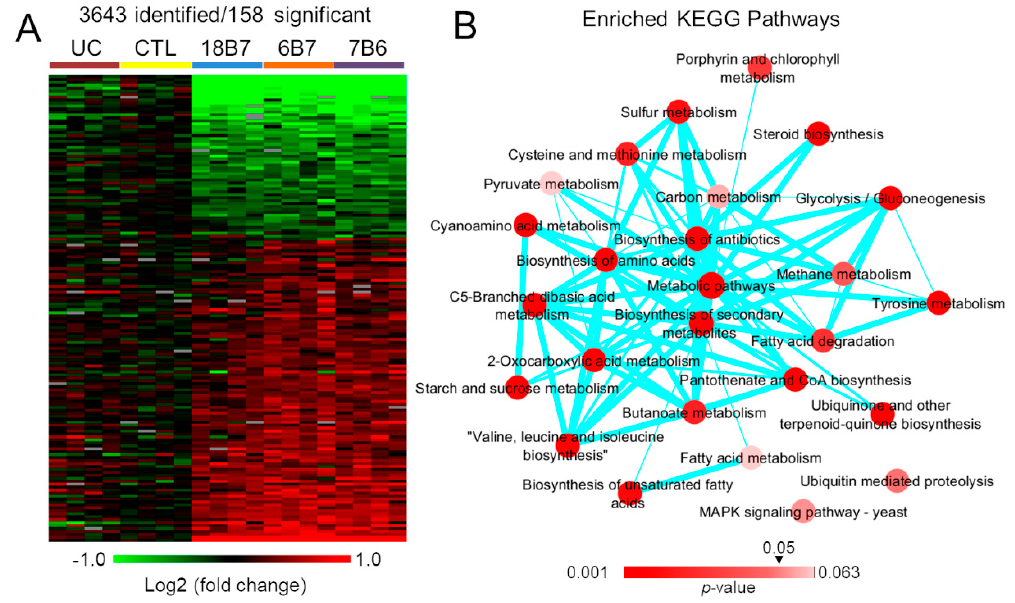
Figure 1. Differentially abundant proteins in Histoplasma capsulatum yeasts treated with monoclonal antibodies 18B7, 6B7 or 7B6 compared to medium control (CTL) and untreated control (UC) yeast cells. ( A ) Heatmap of the 158 differentially abundant proteins (ANOVA p -value ≤ 0.05 and fold change ≥ 1.5). ( B ) Function-enrichment analysis of the differentially abundant proteins based on the Kyoto Encyclopedia of Genes and Genomes (KEGG) annotation. The connectivity of the network was based on the shared proteins between different pathways. The intensity node color is scaled based on the enrichment p -values and the thickness of the edges (lines) represents the degree of shared proteins between pathways.